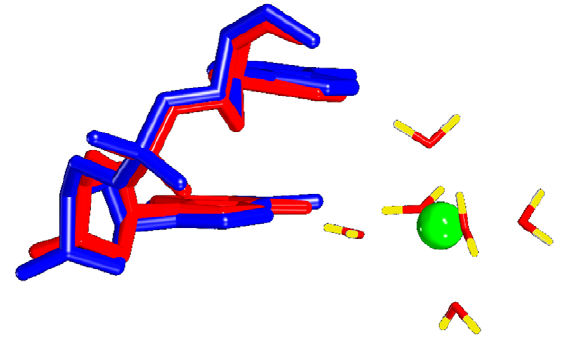
Figure 4. ApG step with and without Mg 2 + . Superimposition of the average structures of A 22 pG 23 either free of Mg 2 + (blue) or binding Mg 2 + (red). In both cases, this step shows the same structural characteristics (low twist, positive roll and BI phosphate group). ApG is thus ideally adapted to the octahedral structure of hydrated Mg 2 + .